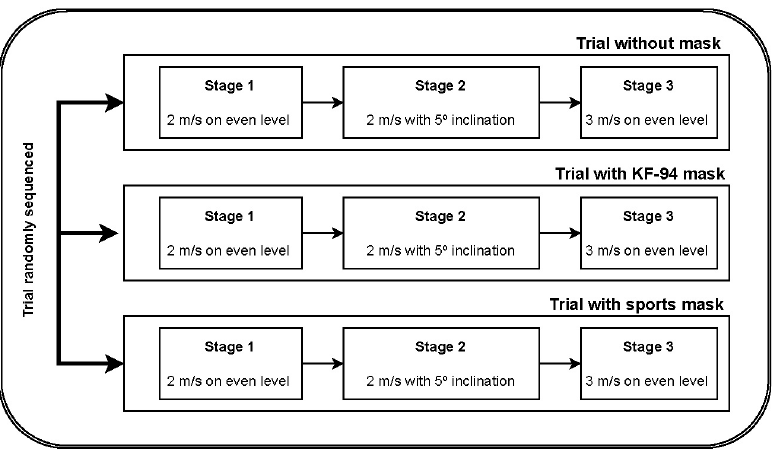
Figure 1. Schematic flow of experiment protocol; 3 trials with 3-stage protocol.